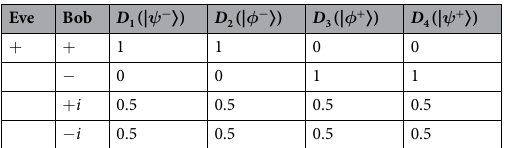
Table 1. Observed intensity arriving at each of Bob’s four detectors when Eve sends | + 〉 . Here, we suppose that the classical optical power threshold of Bob’s blinded detectors P th meets | α | 2 /2 < P th < | α | 2 . The intensities are normalized by | α | 2 .